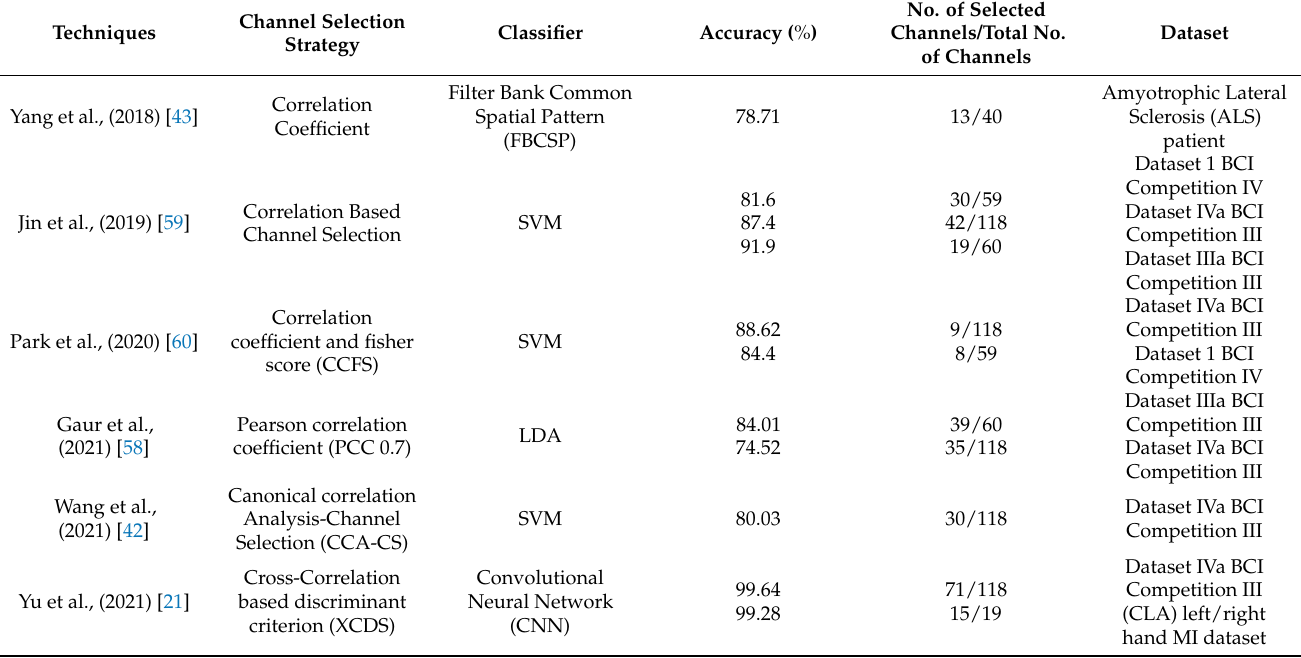
Table 3. Correlation-based techniques for motor imagery EEG channel